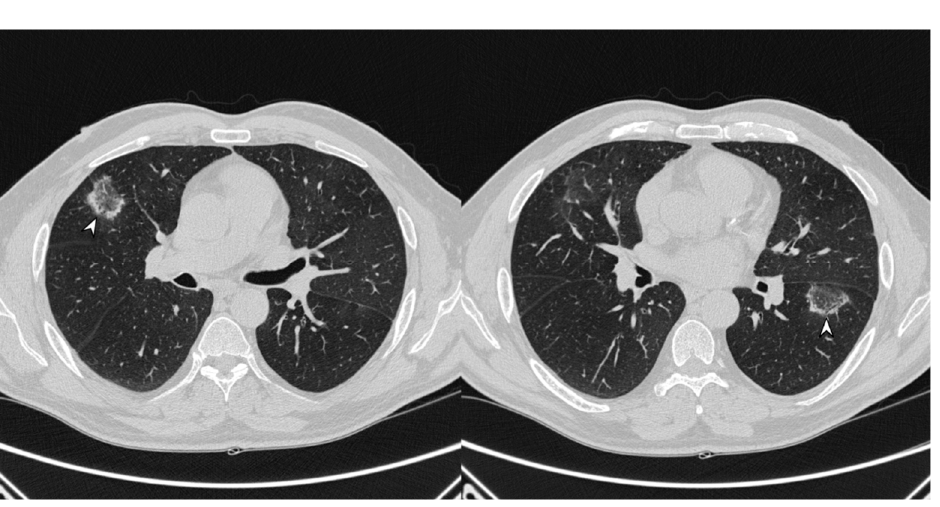
Figure 13. Presence of atoll signs (white arrowheads) in a patient with COP, which were still recognizable despite steroid therapy. Table 8. Evolution of the 4 patients with atoll sign.